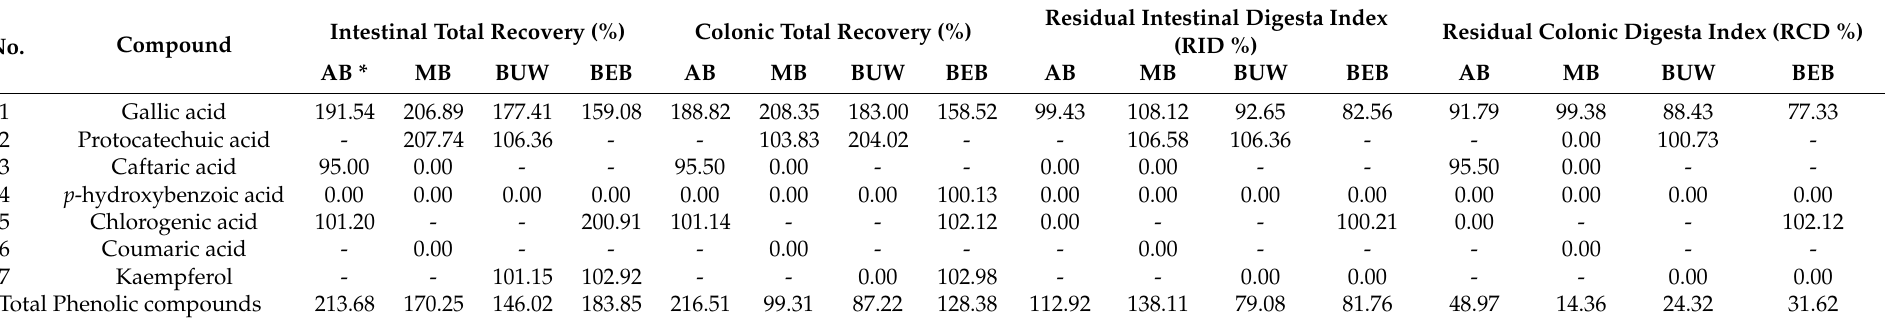
Table 2. Estimation of intestinal total recovery (%), colonic total recovery (%), residual intestinal digesta index (%) and residual colonic digesta index (%) after complete in vitro digestion and colonic fermentation for phenolic compounds of